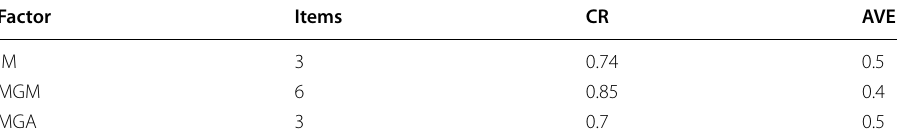
Table 4 Reliability